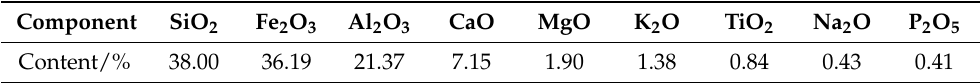
Table 3. Chemical composition of coal